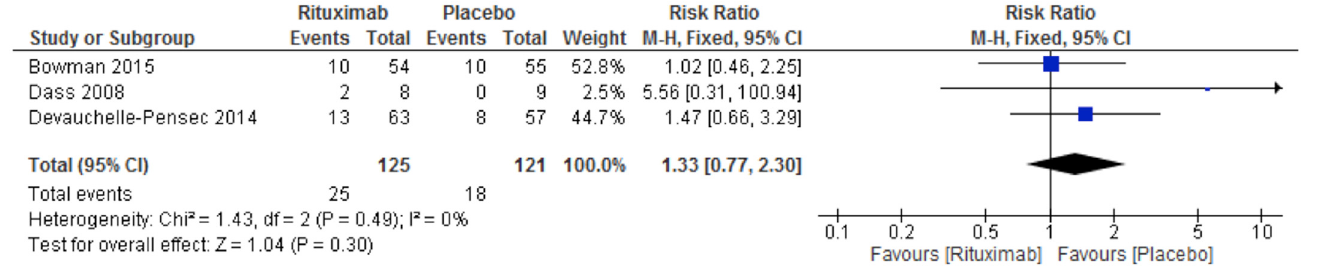
Fig 9. Rituximab X Placebo. Meta-analysis of the outcome serious adverse events at week